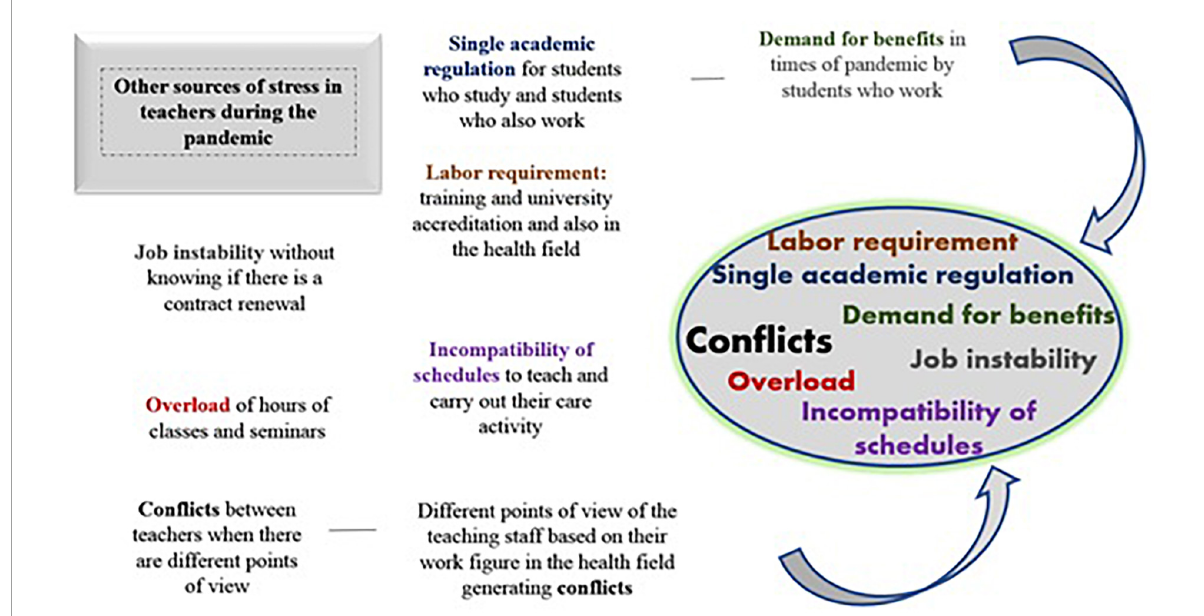
FIGURE1 Digital mind map derived from the open-ended study question and used to illustrate simulation-based answers, feelings, and